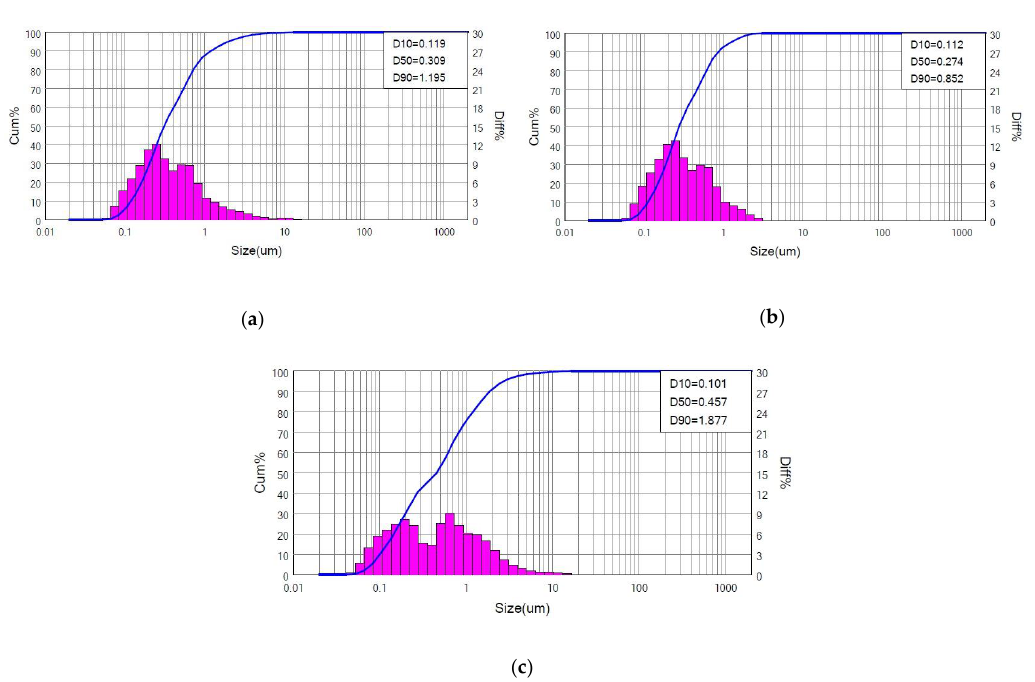
Figure 11. Particle size distribution of ( a ) the recovered cerium oxide abrasive, ( b ) the original cerium oxide abrasive, and ( c ) the abrasive–glass polishing waste (experimental conditions of the recovered cerium oxide abrasive: abrasive–glass polishing waste: approximately 1 g; roasting temperature: 450 ◦ C; mass ratio of polishing waste to NaOH: 1:1; roasting time: 30 min; water leaching pH: 3, leaching temperature: 25 ◦ C, liquid–solid ratio of 25 mL /